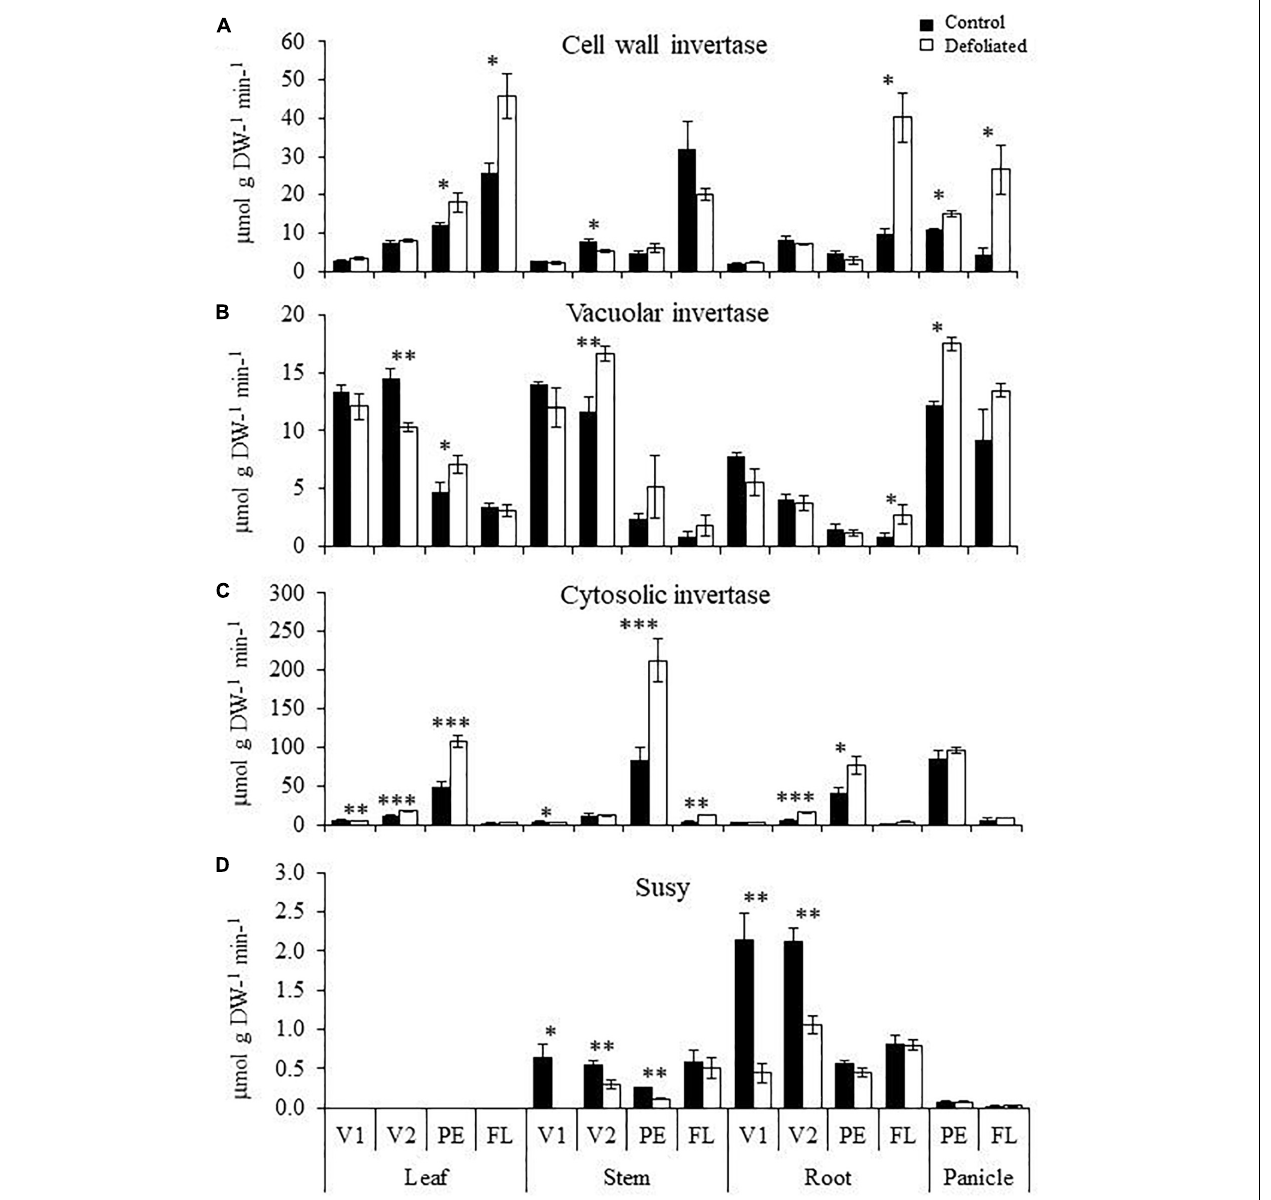
FIGURE 3 | Invertase and sucrose synthase activity in organs of defoliated versus non-defoliated Amaranthus cruentus plants. Levels of (A) cell wall, (B) vacuolar, (C) cytosolic invertase, and (D) sucrose synthase (SuSy) activities were measured in leaves, stems, roots, and panicles of A. cruentus plants subjected to complete defoliation at four different development stages: Vegetative 1 (V1), vegetative 2 (V2), panicle emergence (PE), and flowering (FL). The bars represent the means ± standard error of three technical replicates obtained from three pooled plant samples produced by combining organs from nine individual plants. The results are from a representative experiment that was replicated twice. Asterisks indicate statistically significant differences between treatments at ∗ P < 0.05, ∗∗ P < 0.01, or ∗∗∗ P < 0.001 for a one-way ANOVA, Tukey HSD